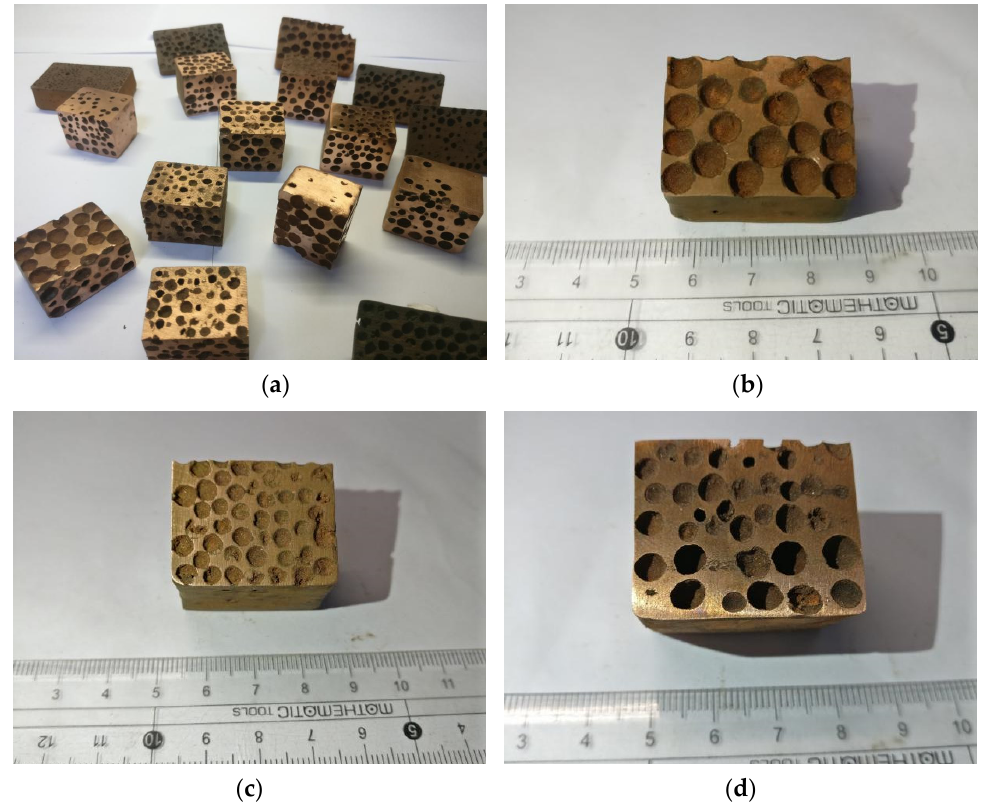
Figure 3. Photos of several closed-cell copper foam (CCCF) samples: ( a ) all kinds of CCCF samples; ( b ) uniform CCCF with pore diameter of 5 mm; ( c ) uniform CCCF with pore diameter of 3 mm; ( d ) graded CCCF with a gradient arrangement of pore diameter (3-4-5 mm).